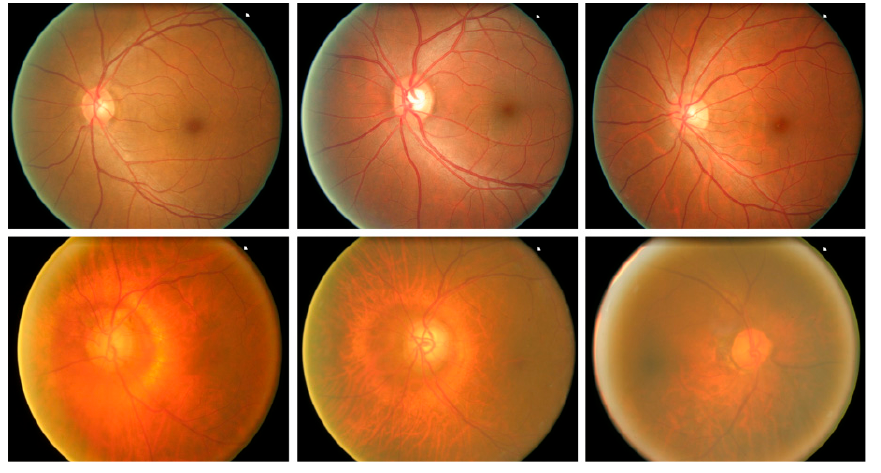
Figure 5. Sample dataset images.